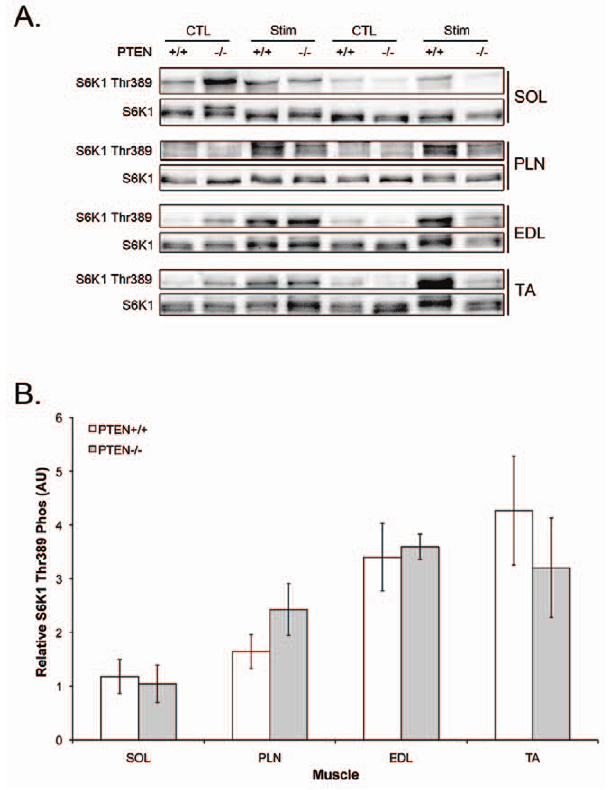
Figure 6. Muscle specific PTEN knockout has no effect of acute phosphorylation of S6K1. Wild type and PTEN 2 / 2 mice underwent a 20-minute intermittent stimulation protocol to determine their acute response to resistance exercise. As observed previously, S6K phosphor- ylation was significantly higher in the TA and EDL muscles than the soleus and PLN. However, there was no difference in S6K1 activation between the wild type and PTEN 2 / 2 mice. Data presented are mean 6 SEM for n=6 animals. * indicates significantly different than the